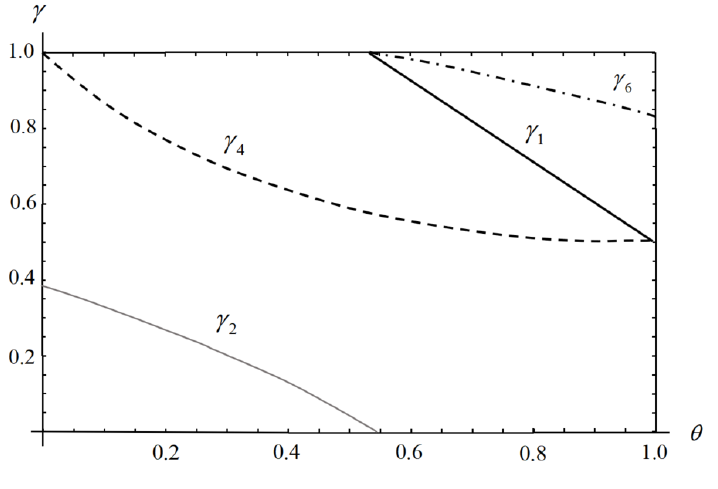
Figure 2. The relationship between , 1,2,4,6 i i .